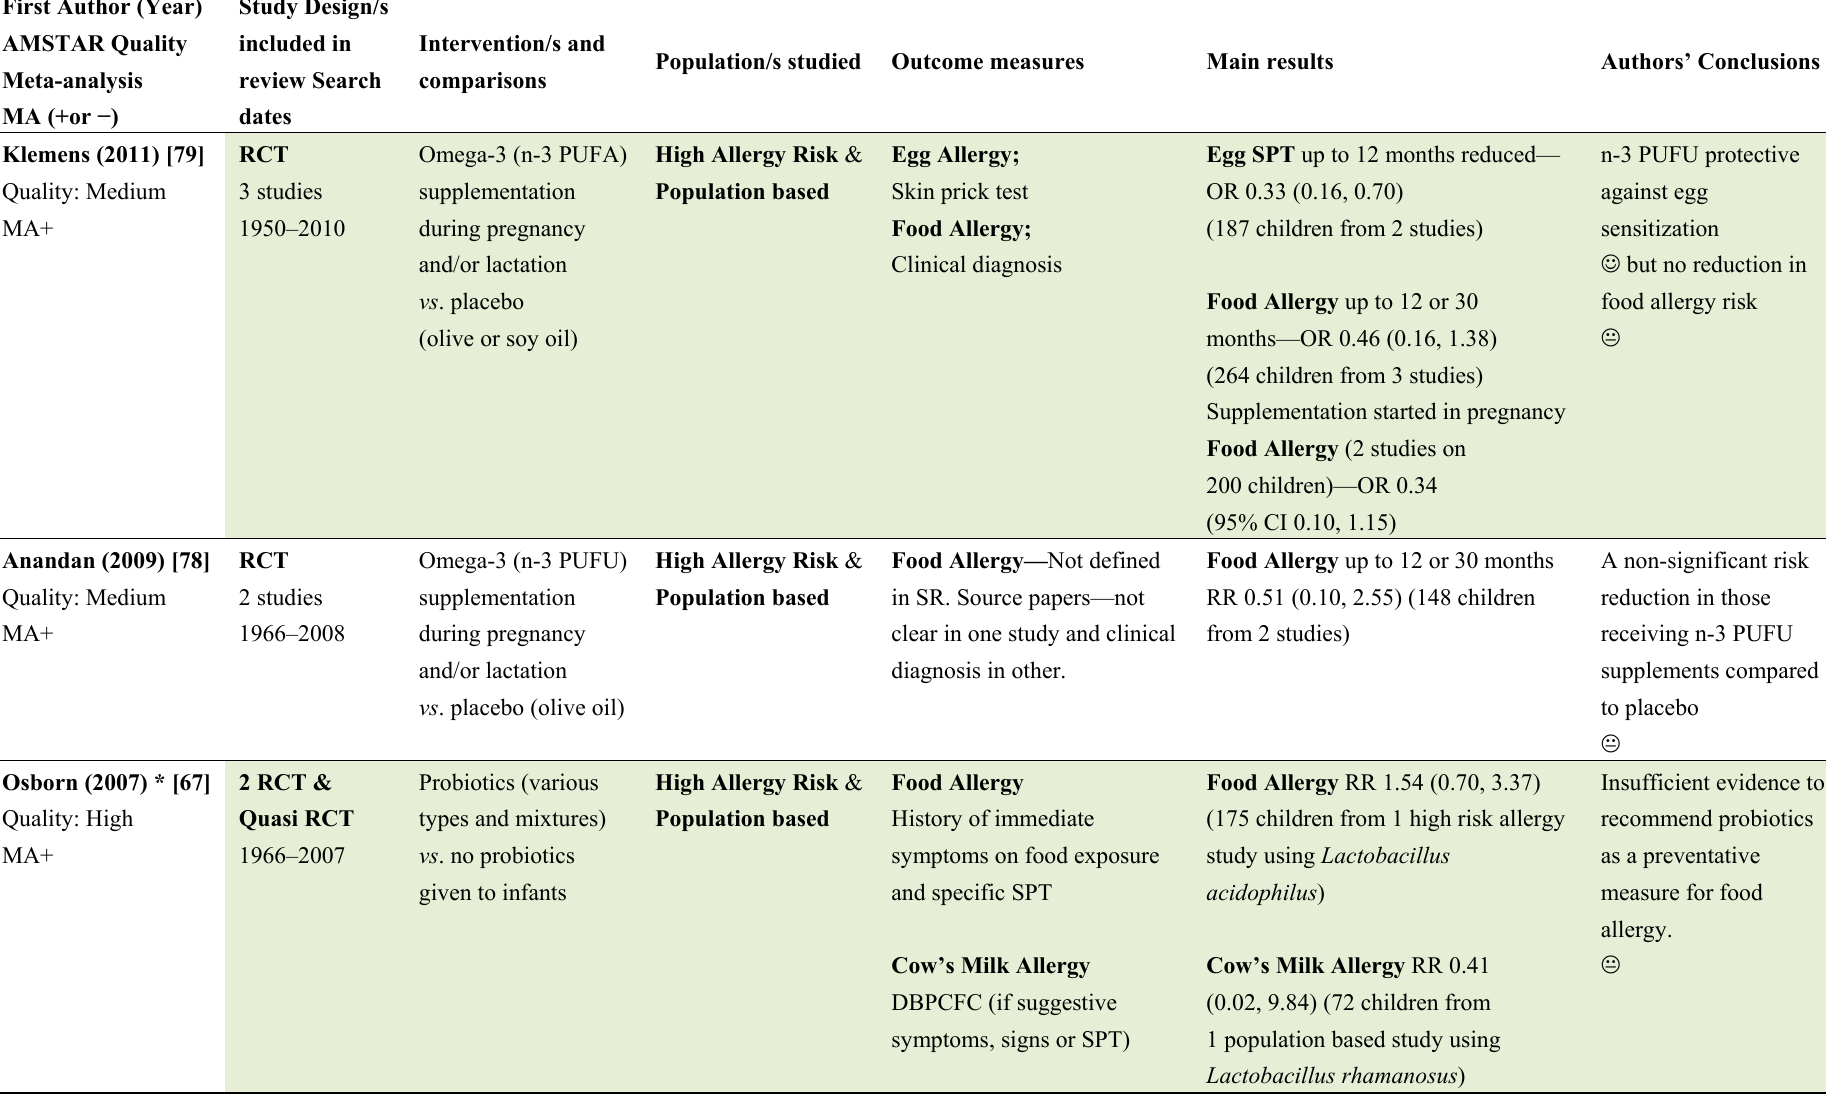
Table 2. Systematic reviews for maternal and infant diet and dietary supplements and the risk of food